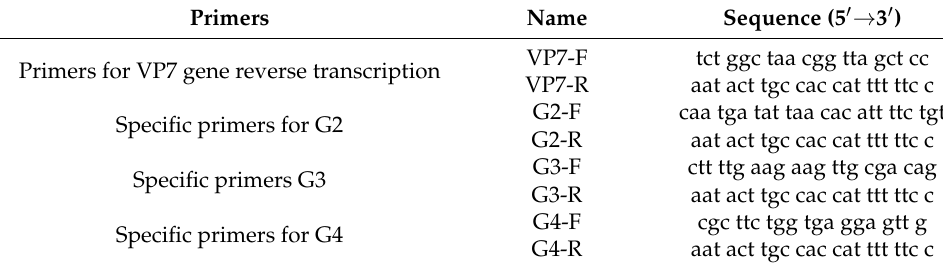
Table 1. Sequence typing primer for G2, G3, and G4